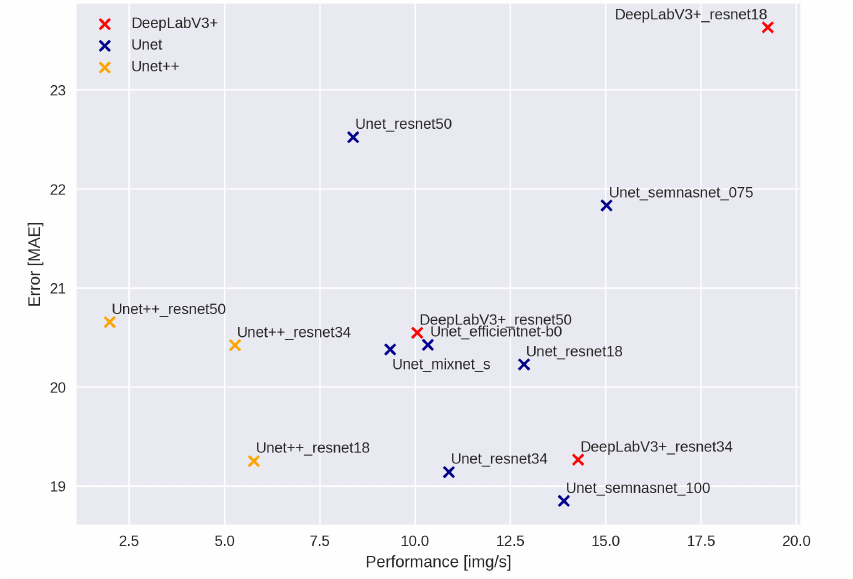
Figure 8. The comparison of models and encoders in terms of achieved performance and accuracy. The chart presents the results for the highest tested resolution (1280 × 736). The performance metric was measured during inference on the Jetson NX